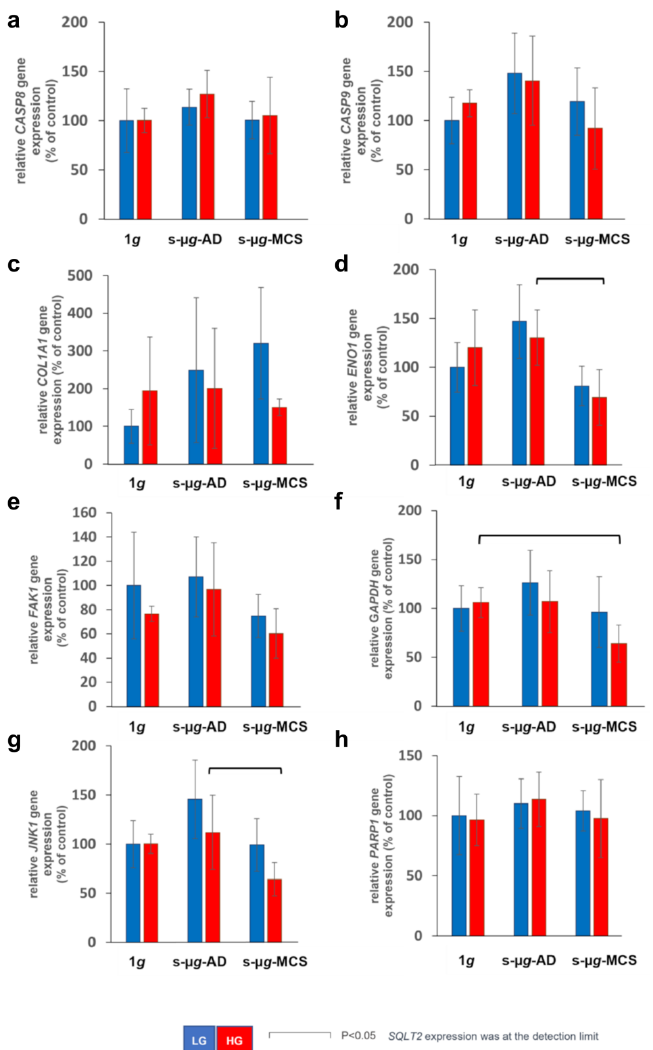
Figure A1. qPCR analysis for other genes assessed in this study. The gene expression of ( a ) CASP8 , ( b ) CASP9 , ( c ) COL1A1 , ( e ) FAK1 , and ( h ) PARP1 , was not significantly altered during the 14-day clinostat exposure and HG treatment. ( d ) ENO1 and ( g ) JNK1 were significantly downregulated in high-glucose s-µ g -MCS cells compared to high-glucose s-µ g -AD cells. ( f ) GAPDH was mostly not regulated during the 14-day s-µ g -exposure and HG treatment, except for HG 1 g control vs. HG MCS.